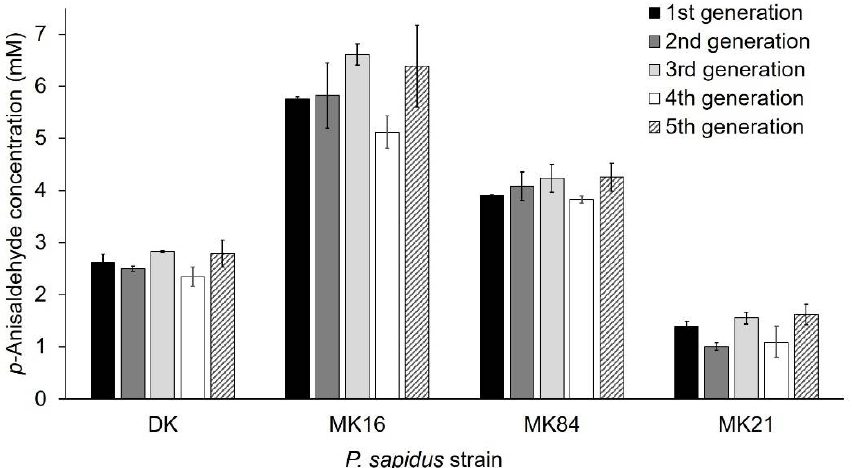
Figure 4. Stability of alkene cleavage activity towards trans -anethole of selected monokaryons and the parental dikaryon over five serial generations. Values are the average of duplicate experiments of two independent biological replicates with standard deviations shown as error bars.